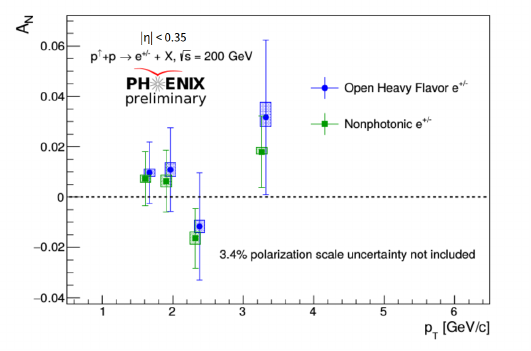
( p ) (blue), nonphotonic e ± A N T